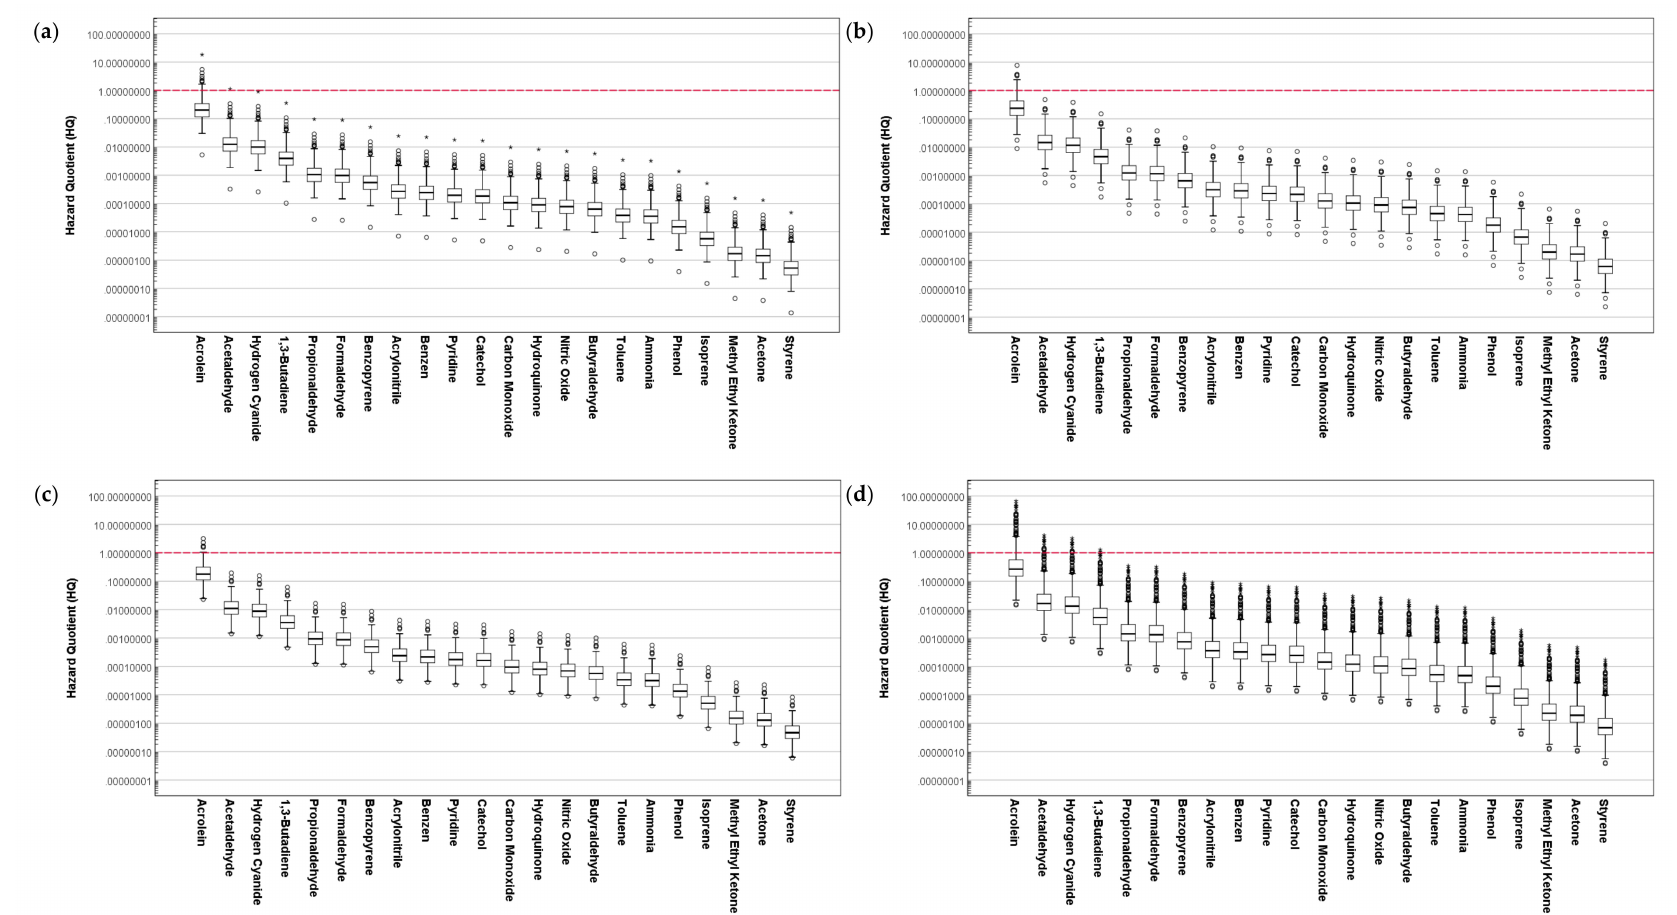
Figure 4. Assessment of hazard quotient for the composition of cigarette smoke to THS exposure subjects based on age: ( a ) 6–10 years old, ( b ) 11–13 years old, ( c ) 14–18 years old, and ( d ) 19 years old and